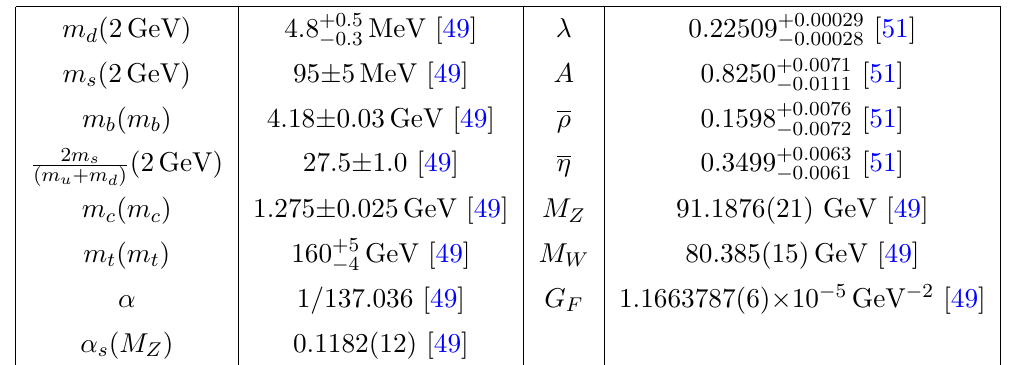
Figure 1 . (cid:3) uu vs j (cid:15) K j in the LR models. The red line corresponds to our prediction. The light blue band is the SM prediction with 1 (cid:27) errors of (cid:17) 1 ; 2 ; 3 : The pink band corresponds to the experimental result [49] .